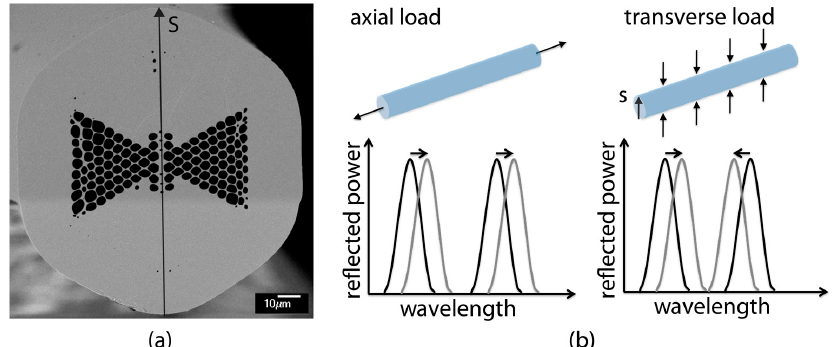
Figure 1. ( a ) SEM image of the cross-section of the fabricated butterfly microstructured fibre (MOF); ( b ) Response of a fibre Bragg grating (FBG) created in the butterfly MOF: axial strain corresponds to both peaks moving in the same way, whilst transverse strain (applied parallel to axis ‘S’) corresponds to the peaks moving in opposite directions [18].